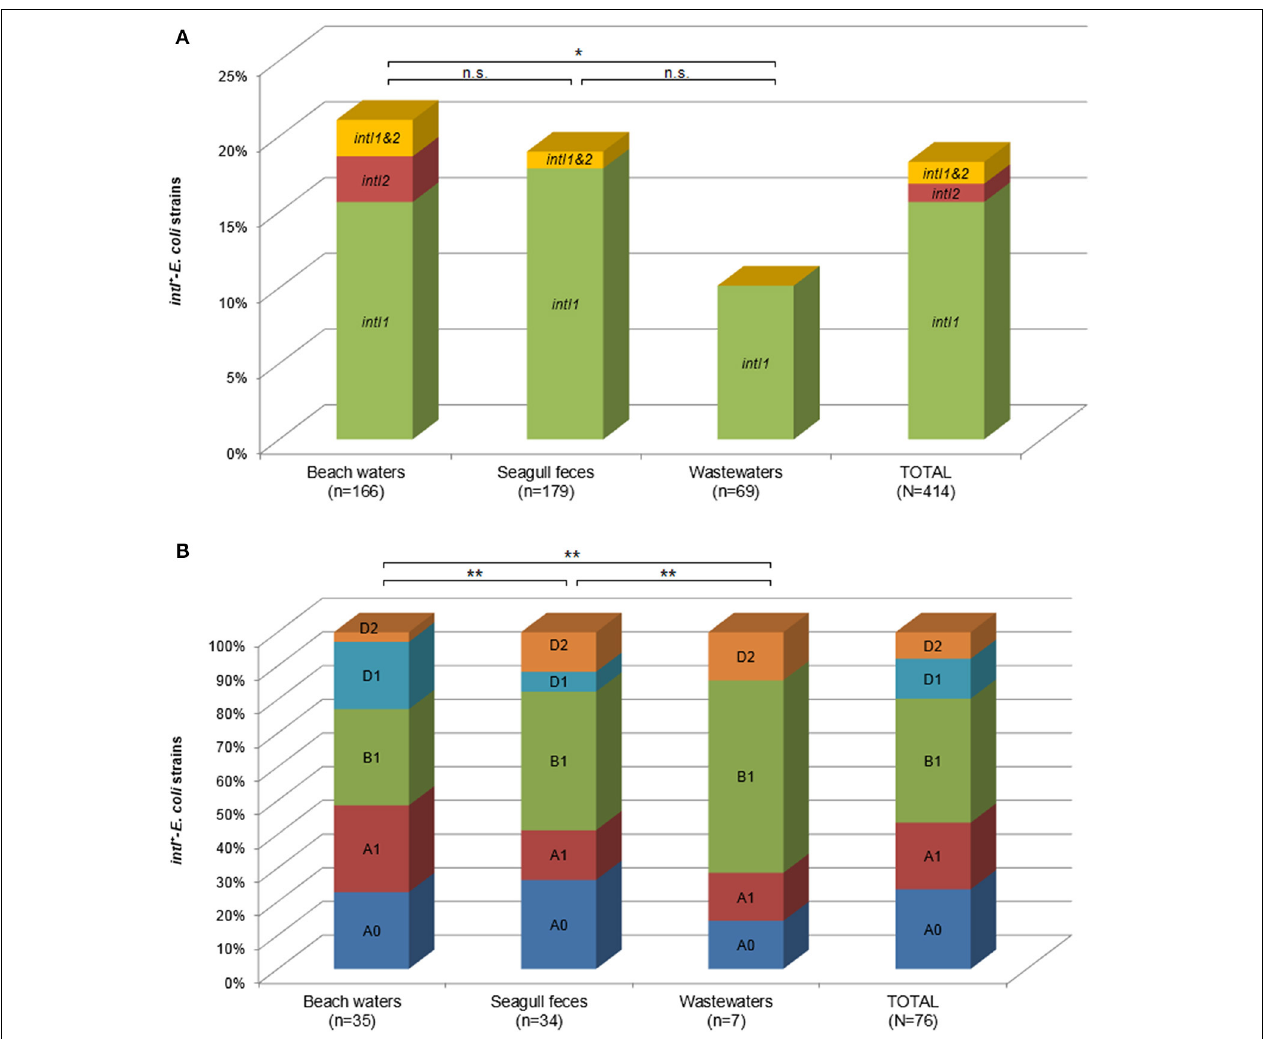
FIGURE 1 | Prevalence of intI + -E. coli detected in the Berlenga Island among different sources (A) and phylogroups (B). Statistical significance: ∗ P < 0 . 05; ∗∗ P < 0 . 01; n.s., not significant.